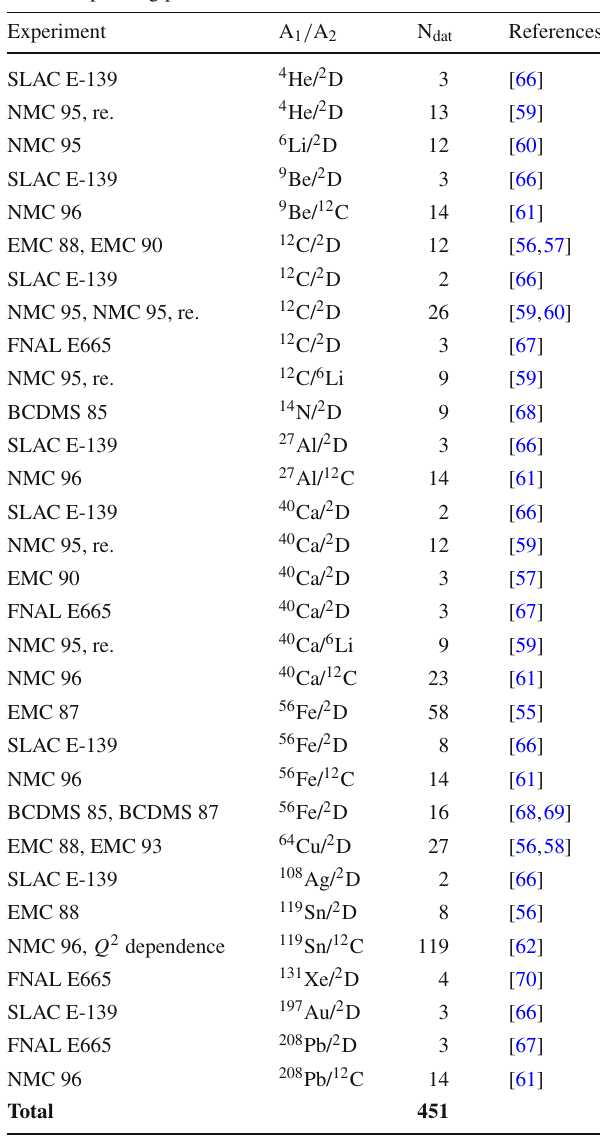
Table 1 The input datasets included in the present analysis. For each dataset, we give the nuclei A 1 and A 2 which have been used in the measurement with their atomic mass number. We also list the number of data points that survive the baseline kinematical cuts, and